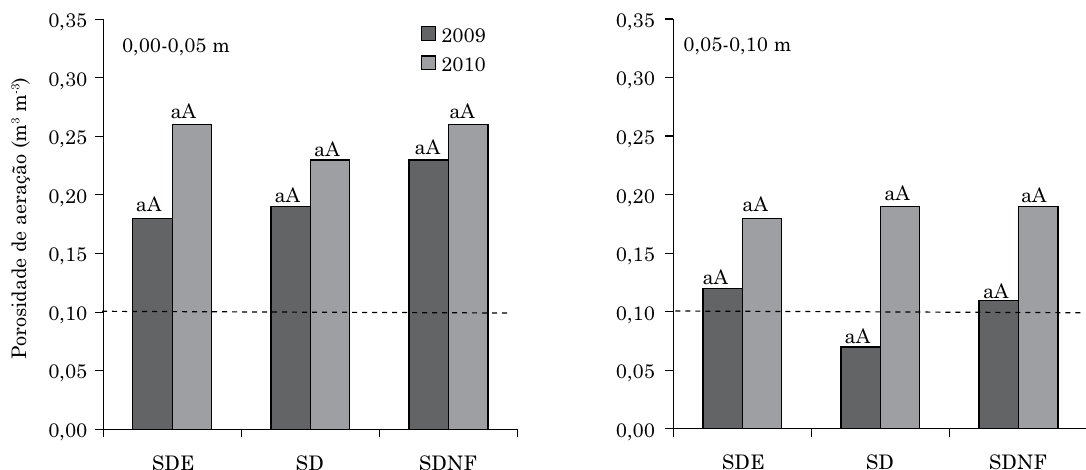
Figura 6. Valores médios da porosidade de aeração (ε a ) na capacidade de campo (-10 kPa) para os tratamentos semeadura direta escarificada (SDE), semeadura direta (SD) e semeadura direta cultivada com nabo forrageiro (SDNF) nas camadas 0,00-0,05 e 0,05-0,10 m para a cama de semeadura do milho (2009) e da soja (2010). Barras seguidas de mesma letra minúscula indicam que as médias entre tratamentos em cada ano para cada profundidade não diferem pelo teste Tukey a 5 %, e seguidas de mesma letra maiúscula as médias entre os anos para cada tratamento e cada profundidade não diferem pelo teste Tukey a 5